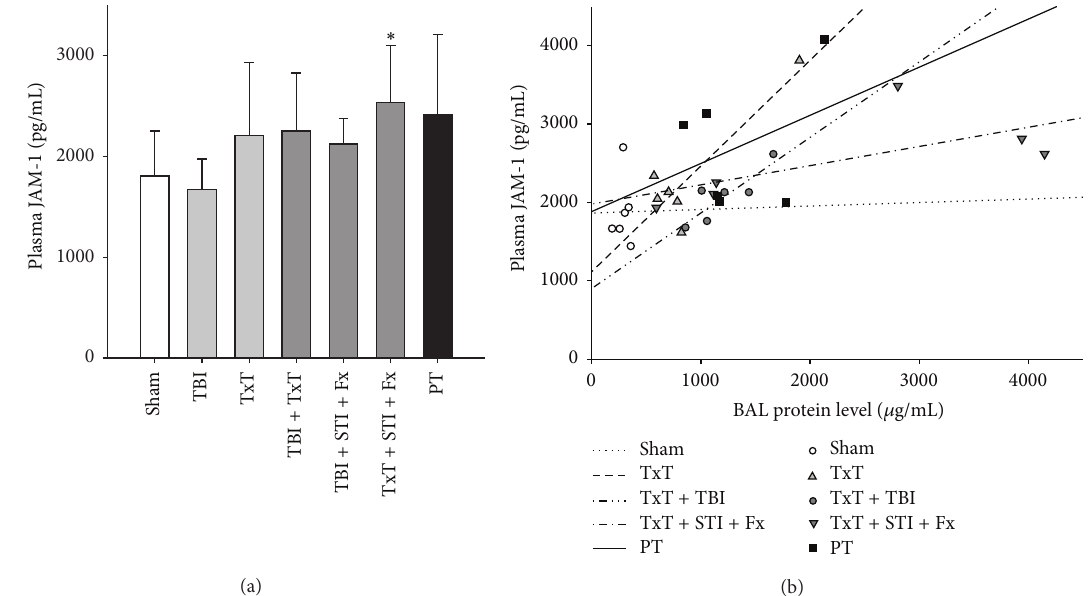
Figure 1: (a) JAM-1 levels in murine plasma 2h after experimental blunt chest trauma (TxT), closed traumatic brain injury (TBI), femur fracture including contralateral soft tissue injury (STI + Fx), and combination of injuries (PT) ( 𝑛 = 6–9 per group) compared to sham procedure ( 𝑛 = 12 ). Results are presented as means ± SD; Kruskal-Wallis ANOVA on ranks followed by Dunn’s method; ∗ 𝑃 ≤ 0.05 versus sham. (b) Correlation analysis was performed between murine JAM-1 plasma levels and protein concentration in bronchoalveolar lavage (BAL) fluids to assess the impairment of the barrier function 2 h after blunt chest trauma (TxT), TxT in combination with traumatic brain injury (TxT + TBI), TxT combined with femur fracture and contralateral soft tissue injury (TxT + STI + Fx), polytrauma (PT), and sham procedure. Pearson correlation coefficient ( 𝑟 ) of plasma JAM-1 versus BAL protein: 𝑟 = 0.01 with 𝑃 = 0.99 (sham); 𝑟 = 0.89 with 𝑃 = 0.02 (TxT); 𝑟 = 0.86 with 𝑃 = 0.03 (TxT + TBI); 𝑟 = 0.67 with 𝑃 = 0.10 (TxT + STI + Fx); and 𝑟 = 0.36 with 𝑃 = 0.48 (PT). Symbols show values for individual animals; lines represent linear regression for the indicated